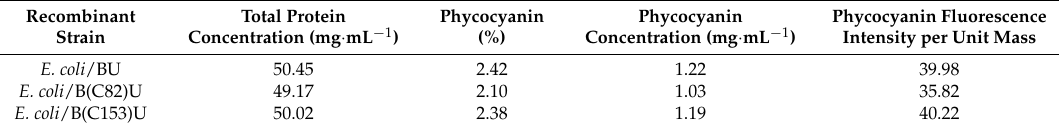
Table 1. Quantitative and fluorescence intensity analysis of phycocyanin in B, BU, BS, and BUS. Recombinant Strain Table 2. Quantitative and fluorescence intensity analysis of phycocyanin in BU, B(C82)U, and B(C153)U. Recombinant Strain